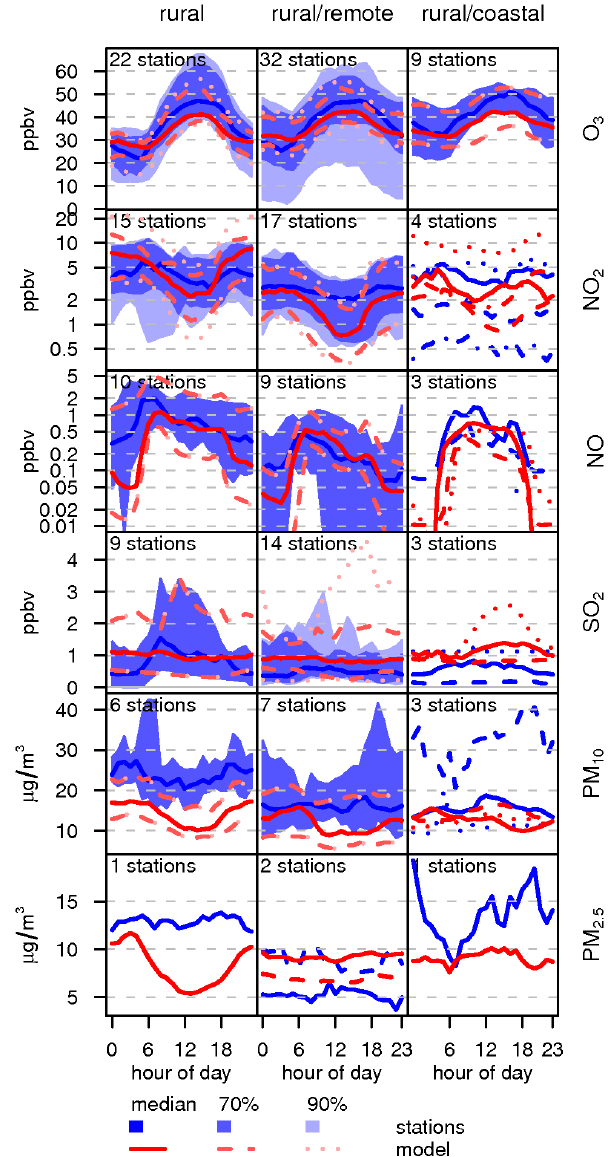
Fig. 5. Modelled and measured (AIRBASE) mean diurnal cycles of several compounds during the summer 2006 period, disaggregated after Henne et al. (2010). Measured values are shown as colored areas, modelled parameters as lines. Light blue areas show 90% range of station values, the range between dotted lines the same for modelled values. Blue colored areas compare to the area between dashed lines (70% range). The median of measured values is a solid, dark blue line, the median of modelled values a solid red line. If less than 5 stations report data, measured and modelled medians are reported as blue and red line pair per station, with different line styles for each pair.